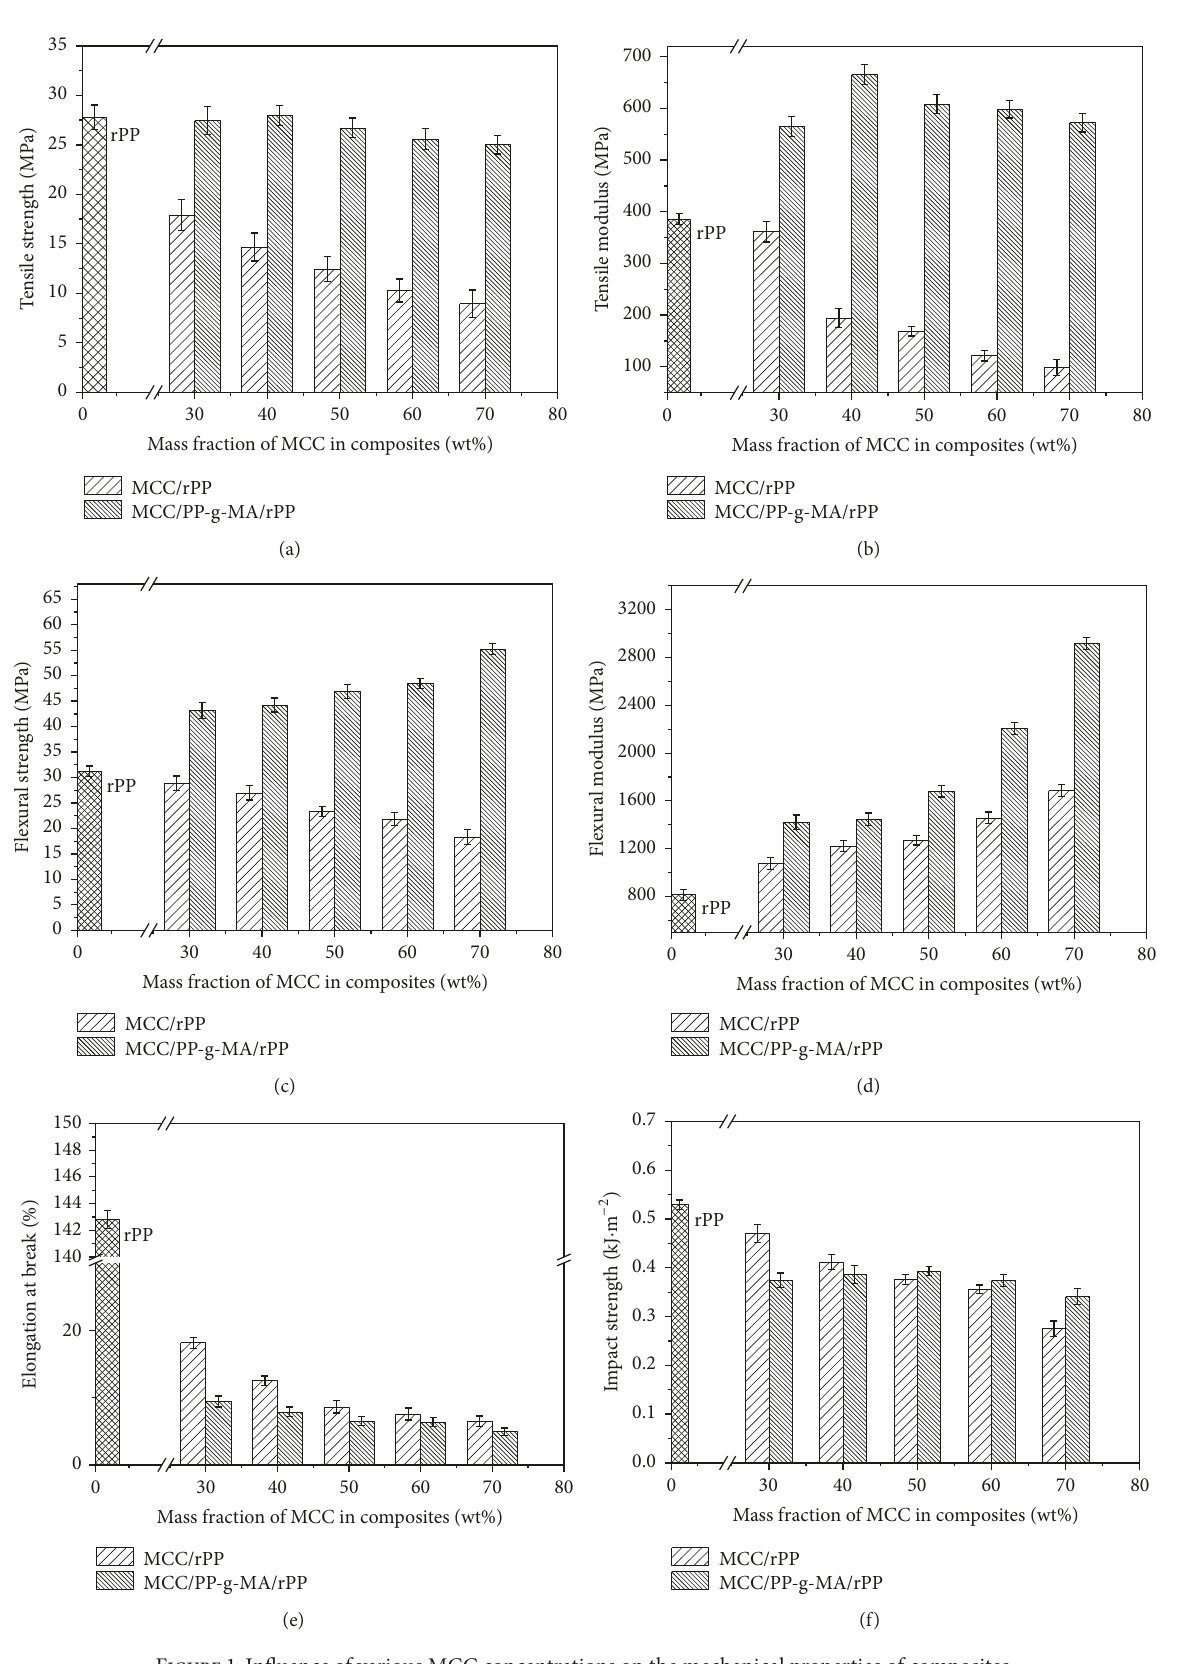
Figure 1: Influence of various MCC concentrations on the mechanical properties of